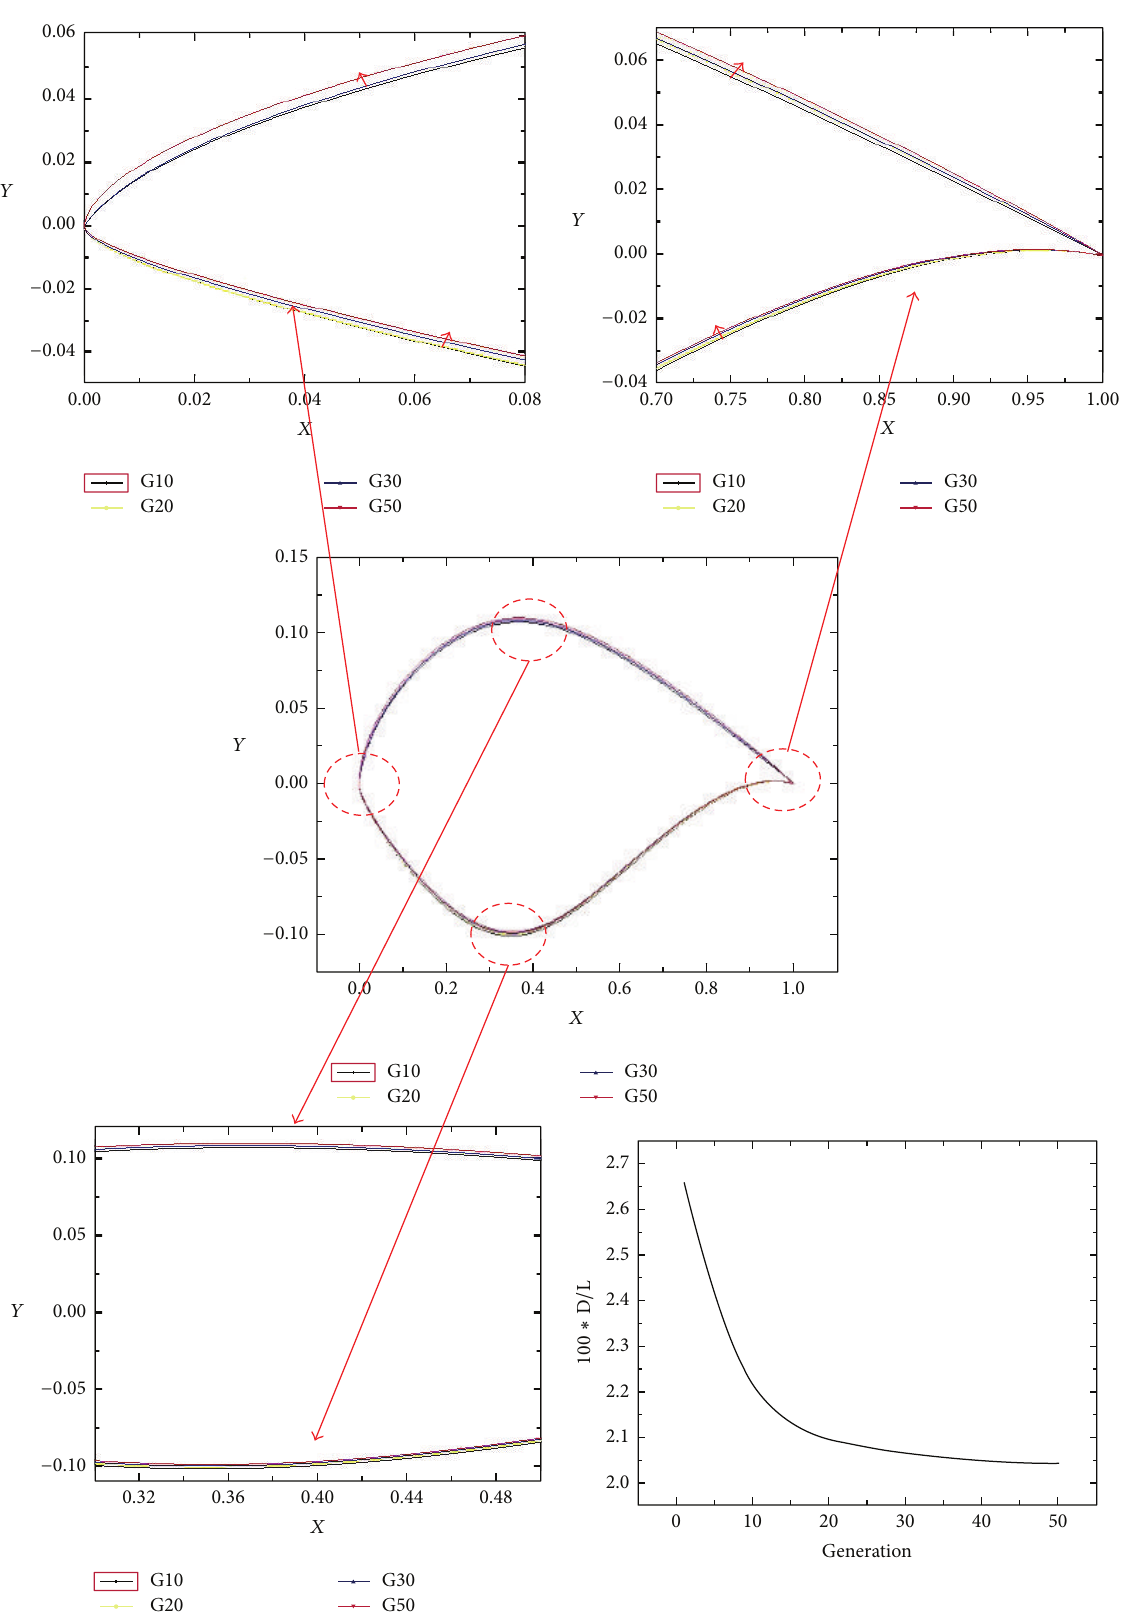
Figure 9: Shape evolution of airfoil and variation in drag to lift ratio at 98% span location in various generations of